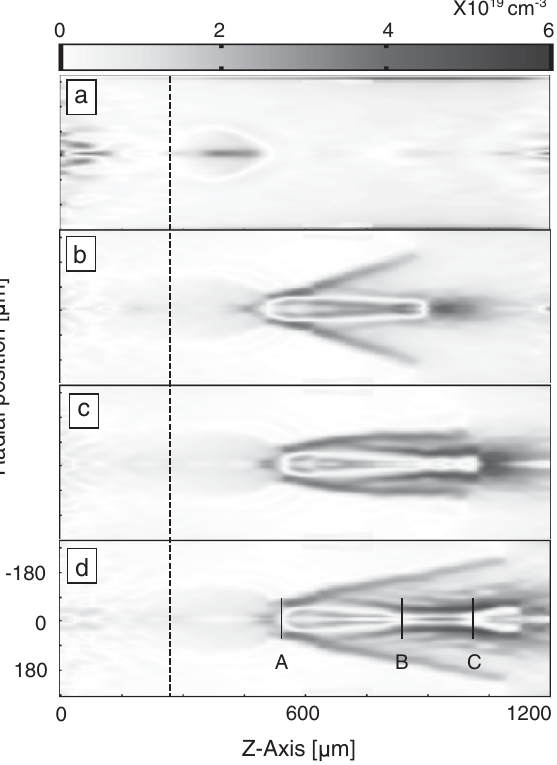
FIG. 7. Restored electron density distribution of the plasma channels for the laser power P ¼ 50 GW (the pulse energy of 90 mJ and pulse duration of 1.8 ps) and N 0 ¼ 1 : 5 (cid:3) 10 19 cm (cid:4) 3 gas density at different times. Parts (a)–(d) show the interfero- grams at different time delays: (a) 1 ps, (b) 3 ps, (c) 5 ps, (d) 9